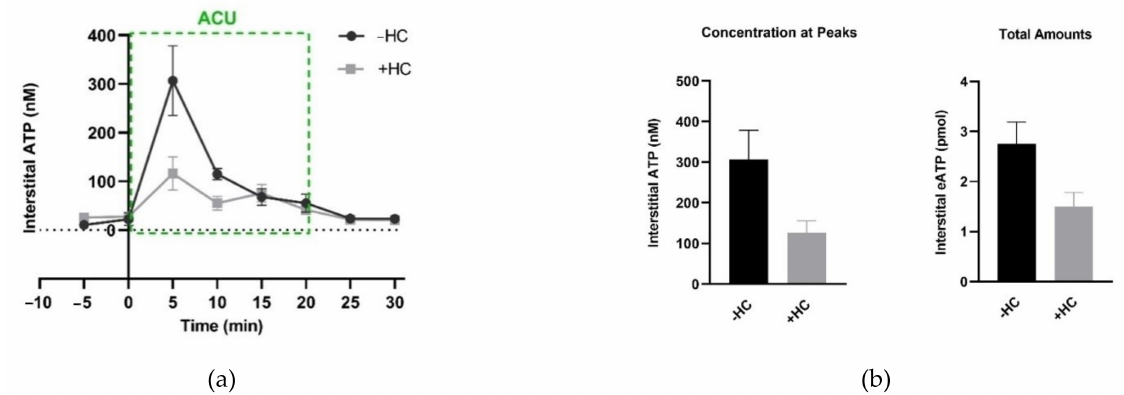
Figure 15. Effect of TRPV4 channel inhibition at the acupoints on needling-induced eATP accu- mulation. ( a ) Time course of eATP changes during AP in the absence and presence of HC067047 (HC) (0.2 mM, 20 µ L), a specific antagonist of TRPV4. Each sample contained 5-min microdialysis. ( b ) Comparison of eATP peaks and the total amounts, respectively, in the absence and presence of HC067047 (0.2 mM, 20 µ L). Graphs are based on the same data as ( a ); eATP amounts were calculated for the area under the curve from 0 min to 20 min. The data represent averages + SEM ( n = 4–5). Figure is from Zheng et al. (2021) [54] with kind permission from